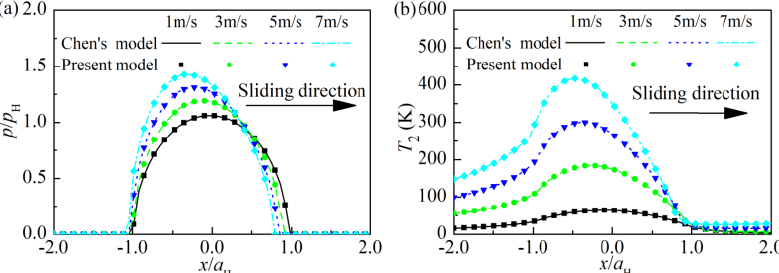
Figure 4. Comparisons on the contact pressure and the surface temperature rise between the present model and Chen’s model under various sliding speeds: ( a ) contact pressure along x axis, ( b ) surface temperature rise along x axis.